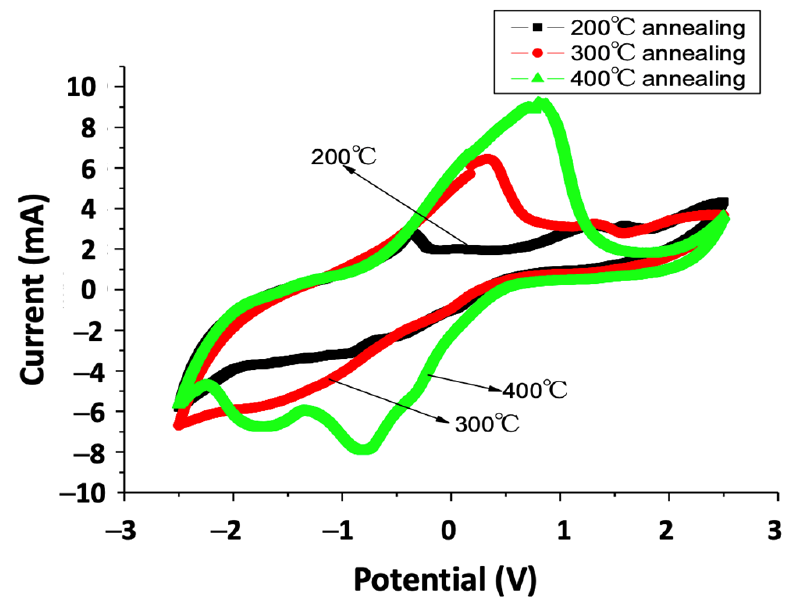
Figure 4. Cyclic voltammetry of the thermal annealed V 2 O 5 thin film. The effectiveness of thermal annealing on the optical properties of V 2 O 5 film was evaluated in the wavelength range from 300 to 1100 nm for the 200 ◦ C-annealed and 400 ◦ C- annealed samples and in the wavelength range from 300 to 1000 nm for the 300 ◦ C-annealed sample. The results are shown in Figure 5a–c. The three curves in Figure 5 include the original specimen (without bias), oxidation state (bias at +2.5 V), and reduction state (bias at − 2.5 V). They are shown in order of the curves as a black square, red circle, and green triangle. The transmittance difference is defined as ∆ T = T bleach − T color at the incident wavelength of 650 nm. Table 1 is the summary of the transmittance difference, charge capacity, and coloration efficiency of the V 2 O 5 thin film after various annealing temperatures. Table 2 shows the photographs of the original, bleached, and colored states of the V 2 O 5 thin films without and after various thermal annealing temperatures. The ∆ T value at the 650-nm wavelength of the unannealed V 2 O 5 thin film is 15%, as revealed in our previous work [39]. As it was annealed, the transmittance difference increased to 31% for the 400 ◦ C-annealed sample due to the grain growth of the film’s polycrystalline structure created by the rearrangement of atoms through thermal energy. The crystalline laminated structure facilitates the intercalation of Li + ions and promotes the charge storage capacity. These effects lead to increased transmittance differences between bleached and colored states. Photographs of the original, bleached, and colored V 2 O 5 films are shown in Table 2. It is known that the color of bleached V 2 O 5 film is yellow, and the colored V 2 O 5 film is gray [6]. The unannealed, 200, and 300 ◦ C-annealed samples showed similar results in our study. The photograph of the colored 400 ◦ C-annealed V 2 O 5 thin film showed a dark green color. For the 400 ◦ C-annealed V 2 O 5 thin film, an increase in the order of polycrystalline structure was detected by the XRD analysis. The transmittance of the 400 ◦ C-annealed sample had an overlaid spectrum of the original and oxidation (bleached) state in the wavelength between 400 and 700 nm, as shown in Figure 5c. Moreover, the reduced (colored) state of the 400 ◦ C-annealed sample had a blue shift at the absorption edge of the transmittance spectrum. S.F. Cogan et al. [39] reported that in response to lithium intercalation, the fundamental optical absorption edge of V 2 O 5 shifts to